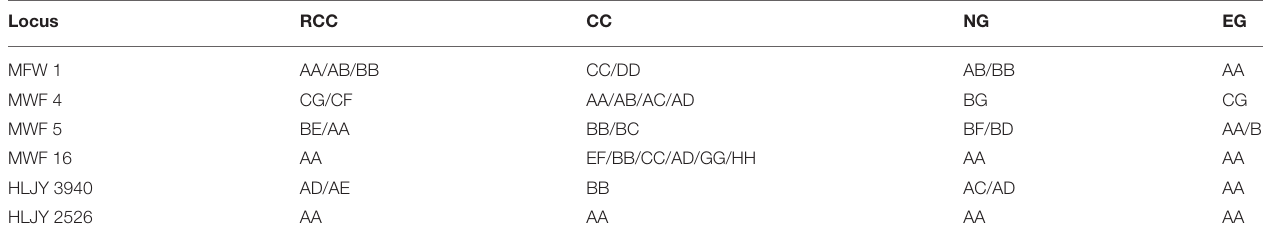
TABLE 1 | Simple sequence repeat (SSR) genotypes of the four fish lines included in this study: red crucian carp (RCC, Carassius auratus ); common carp (CC, Cyprinus carpio ); natural goldfish (NG, Carassius auratus ); experimental hybrid goldfish (EG). Locus RCC CC NG EG MFW 1 AA/AB/BB CC/DD AB/BB AA MWF 4 CG/CF AA/AB/AC/AD BG CG BE/AA BB/BC BF/BD AA